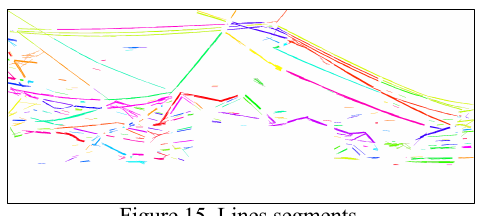
Figure 14. Extraction of cable regions